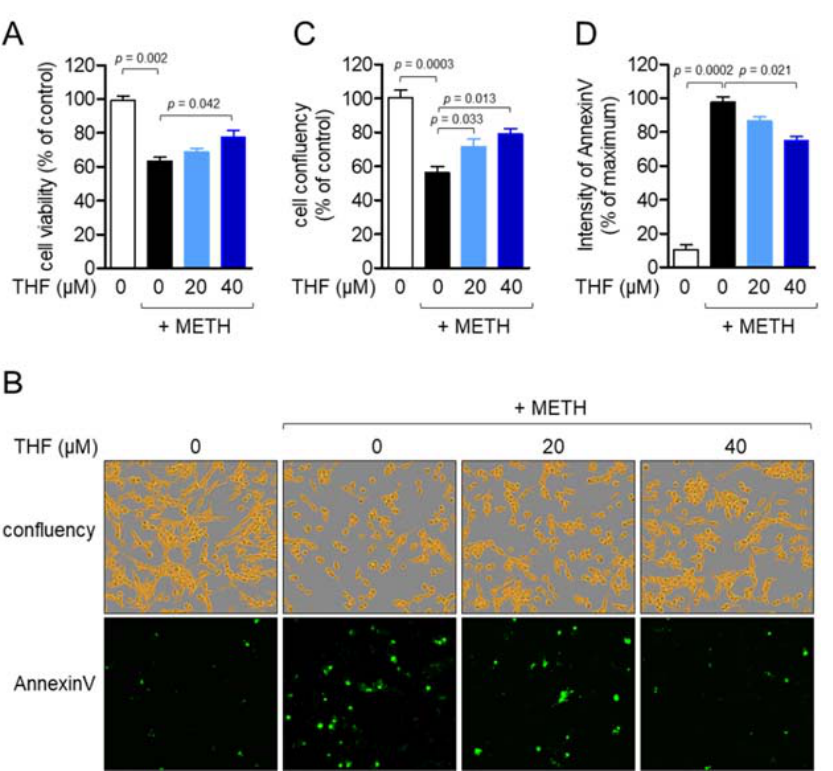
Figure 2. ( A ) SH-SY5y cells (1 × 10 4 /well, 96-well plate) were pretreated with the indicated concen- tration of THF for 6 h and then exposed to 2 mM methamphetamine (METH) for an additional 24 h. Cell viability was assessed by the methyl thiazol tetrazolium (MTT) assay and the percentage of the control was calculated based on the resulting OD value. ( B – D ) SH-SY5y cells (1 × 10 4 /well, 96-well plate) were stained with 1 × annexin V staining reagent and then pretreated with the indicated concentration of THF for 6 h. The cells were exposed to 2 mM METH for 24 h, and fluorescent images were obtained using the IncuCyte imaging system ( B ). Adherent cells are shown in yellow. ( C , D ) Confluency ( C ) and the intensity of annexin V ( D ) were calculated and presented as the percentage of the control for ( C ) and the percentage of the maximum for ( D ), respectively. Results are shown as the mean value of three experiments ± SEM in the bar graph. p value between two indicated